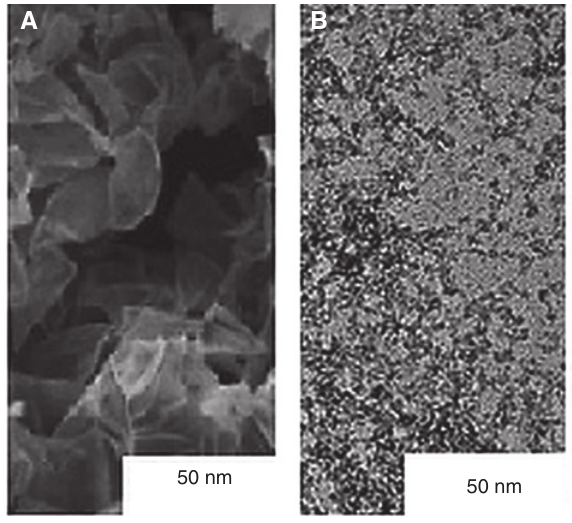
Figure 1: Scanning electron microscopy (SEM) analysis of graphene oxide (GO) and Pd/reduced GO (rGO); (A) SEM image of GO; (B) SEM image of